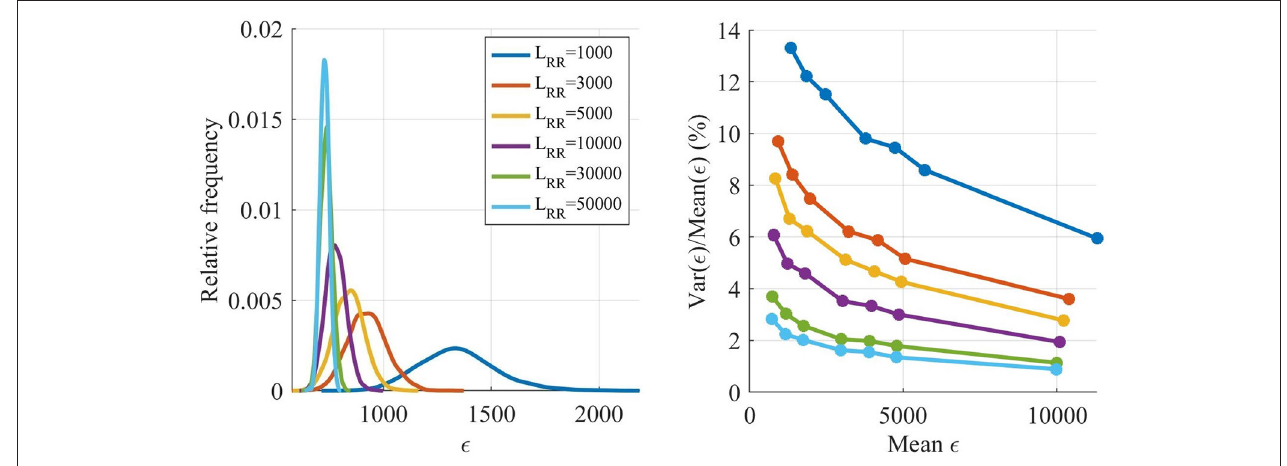
FIGURE 4 | Estimated distribution of ǫ as a function of L RR (left) . Variance of ǫ divided by mean of ǫ as a function of the mean of ǫ (right) .